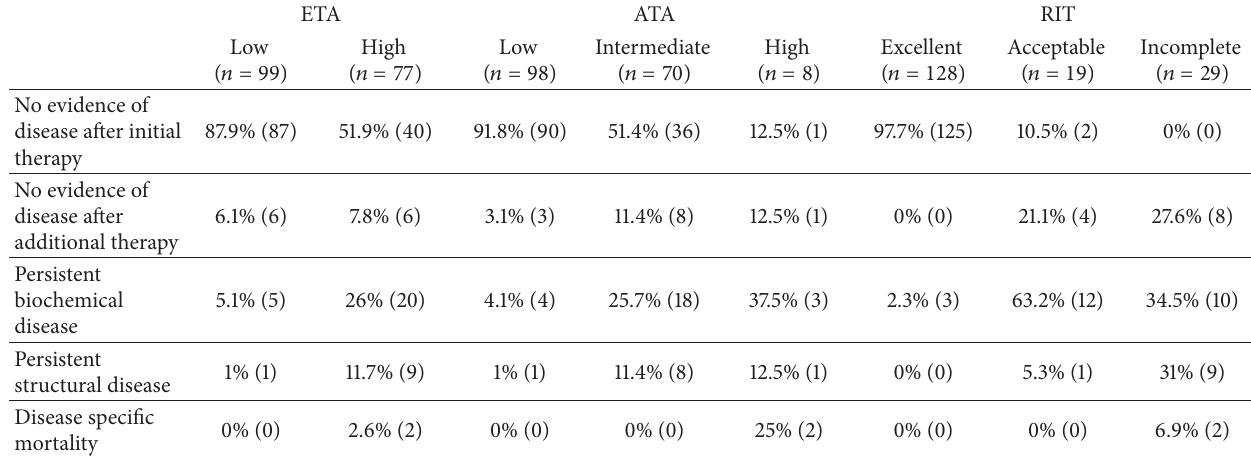
Table 3: Clinical endpoints for each risk stratification system.